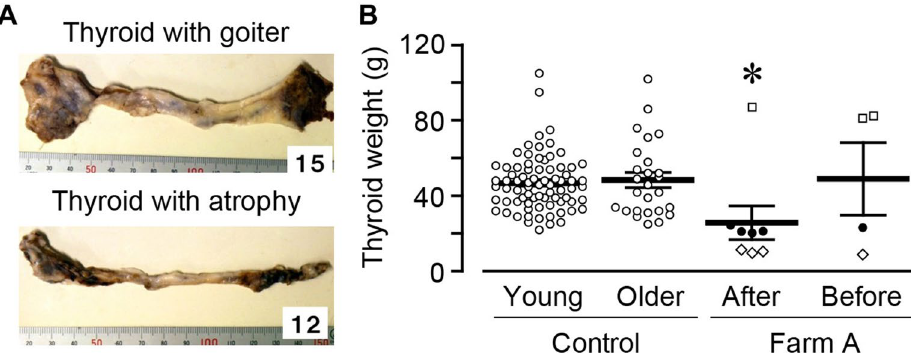
Figure 3. The thyroid weight of exposed cattle. Thyroids were dissected and the weight was measured. ( A ) The representative picture of dissected thyroids with goiter (upper panel) or atrophy (lower panel) in Farm A. Both pictures were taken in October 2013. ( B ) The summary of thyroid weight (Control, open circle, n = 76 and 26; Farm A, black circle (normal), open square (goiter), and open rhombus (atrophic thyroid), n = 8 and 4). Data are presented as mean ± SEM. *P < 0.05 compared with the control